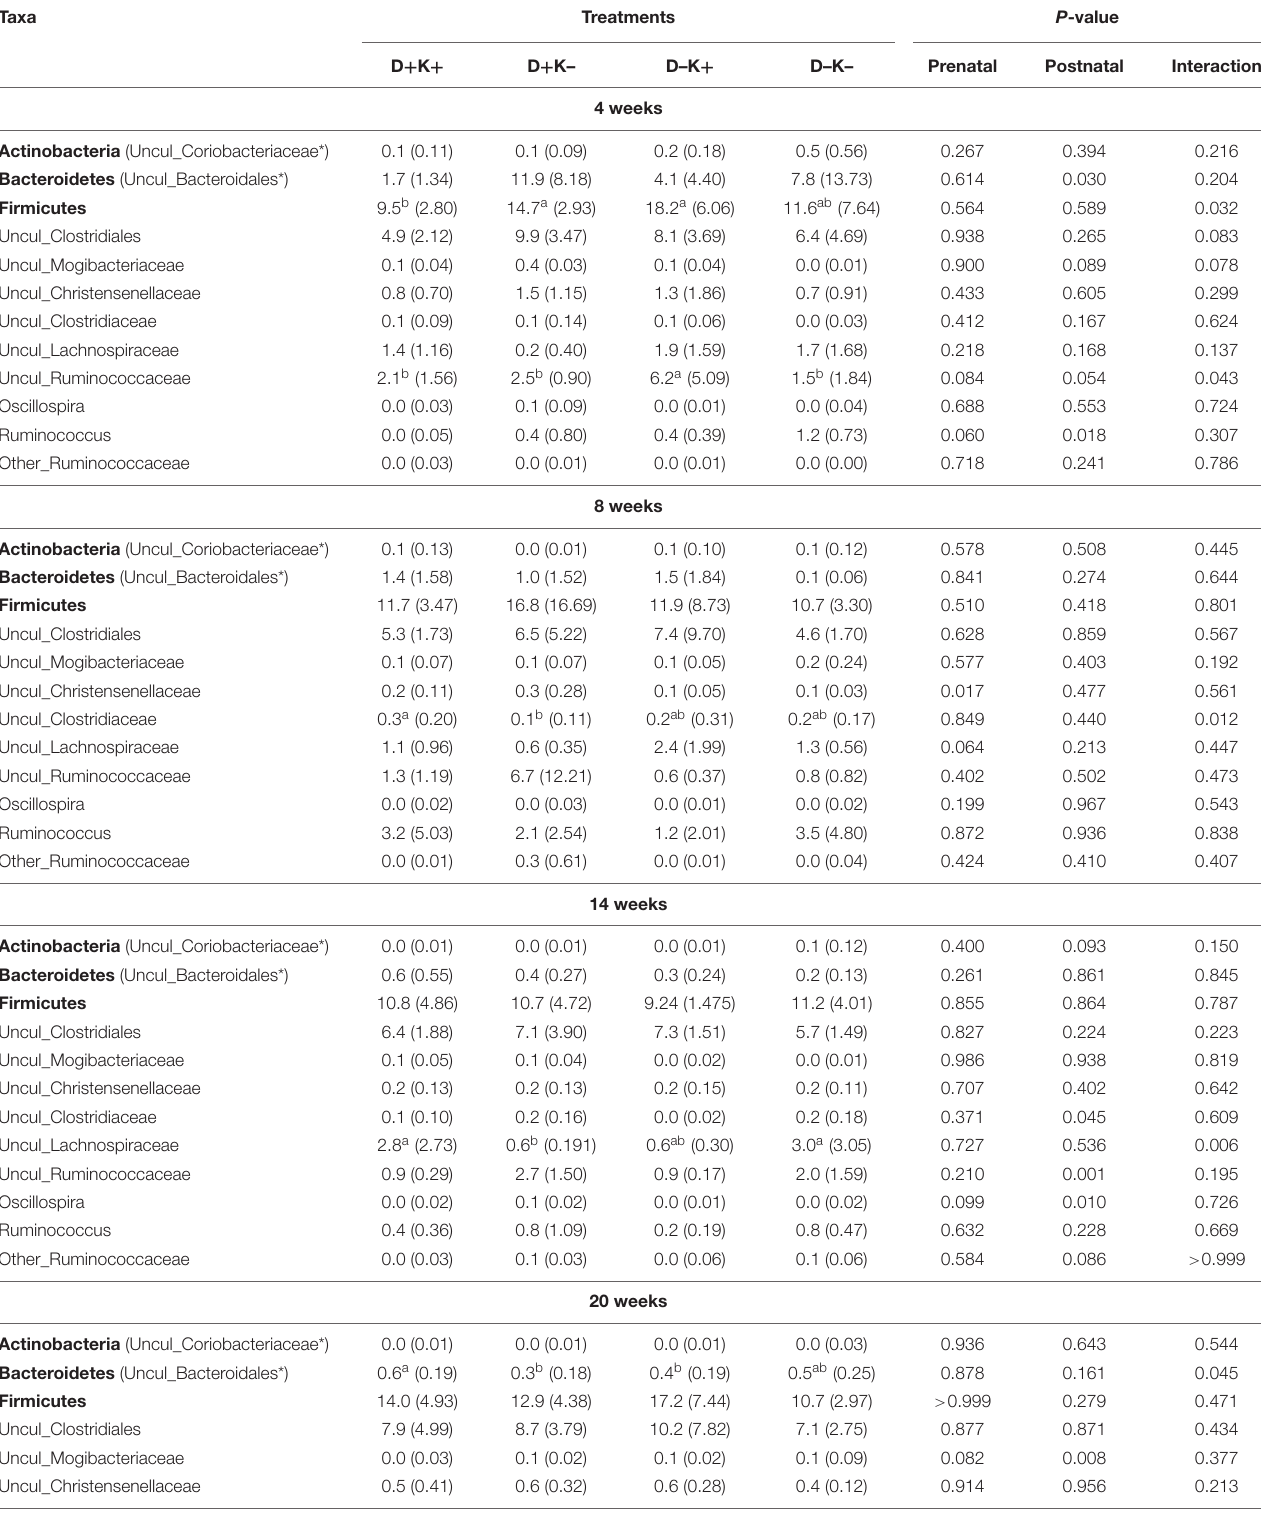
TABLE 3 | Mean (standard deviation) of the relative abundance (%) of the core-persistent microbiome (phyla [in bold ] and genus level) which were observed in 80% of the goat kids irrespective of treatment at 4 weeks of age and that persisted through 8 and 14 weeks of age till 20 weeks of age. Taxa Treatments P